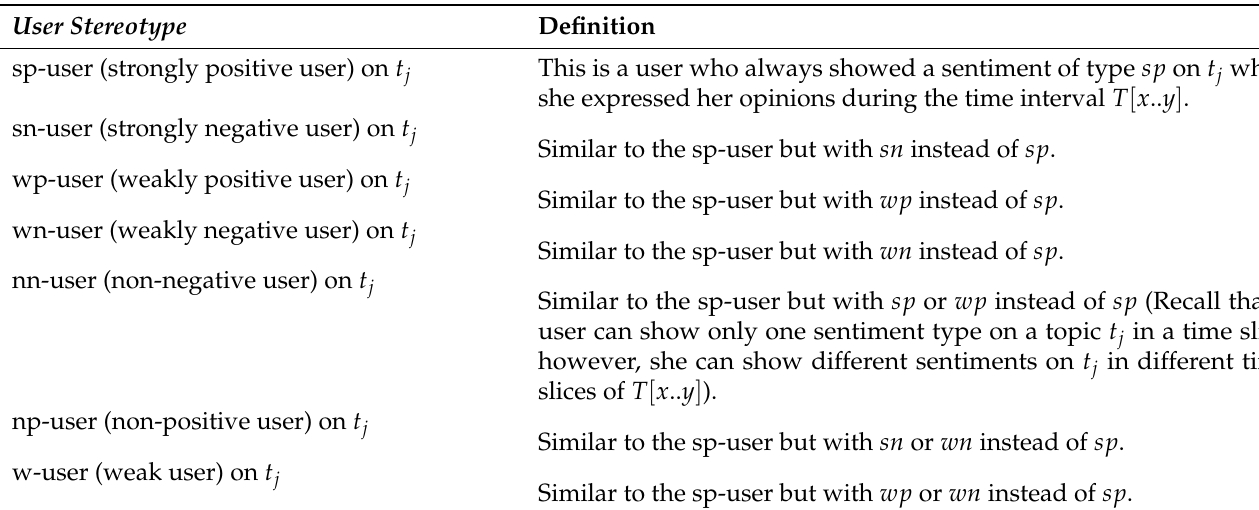
Table 9. Some possible user